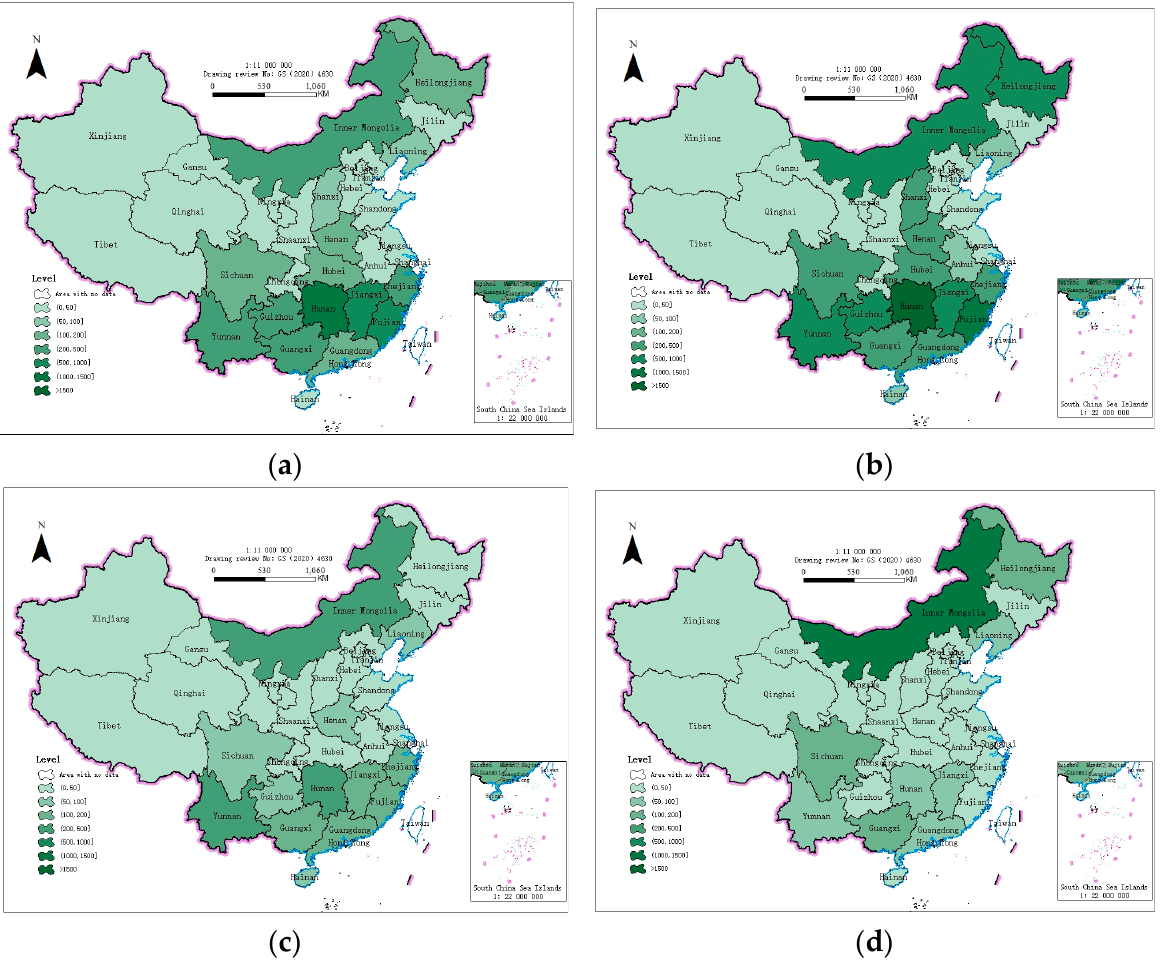
Figure 3. Spatial distribution of forest fire economic loss in China. ( a ) Total economic loss caused by forest fires in China’s provinces from 2007 to 2009. ( b ) Total economic loss caused by forest fires in China’s provinces from 2010 to 2012. ( c ) Total economic loss caused by forest fires in China’s provinces from 2013 to 2015. ( d ) Total economic loss caused by forest fires in China’s provinces from 2016 to 2018.